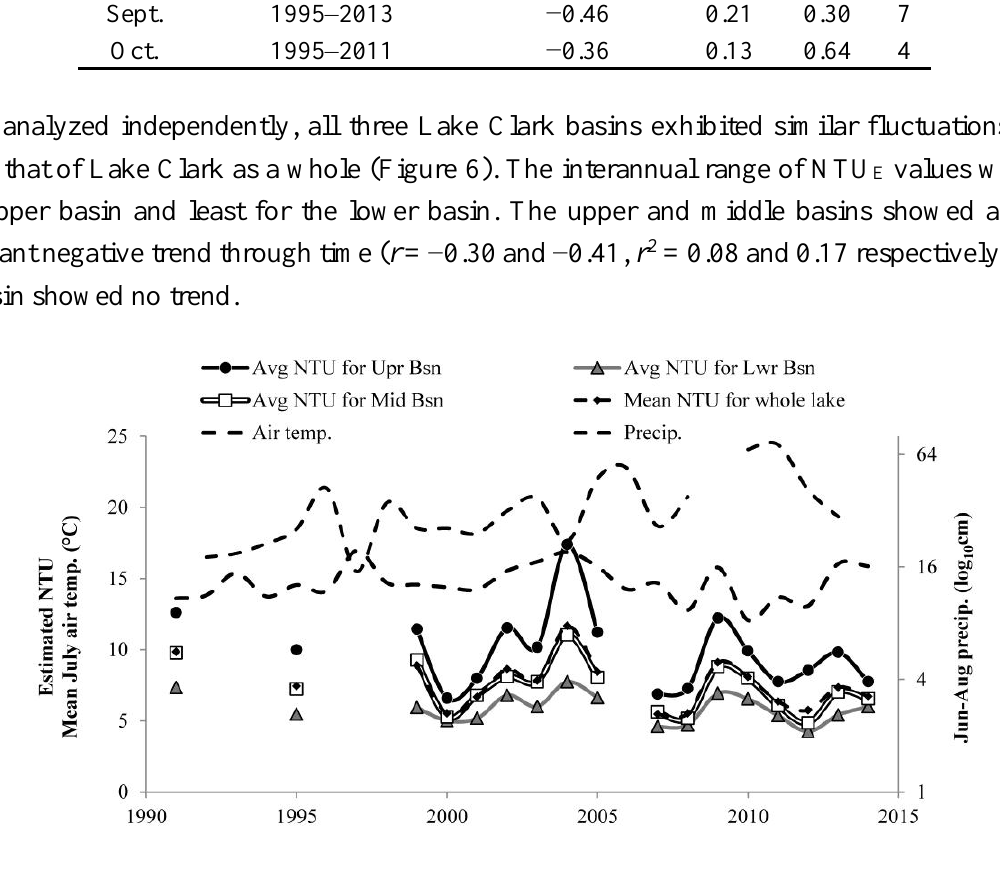
Figure 6. Average turbidity for the entire lake as well as each basin based on all whole-lake scenes (n =